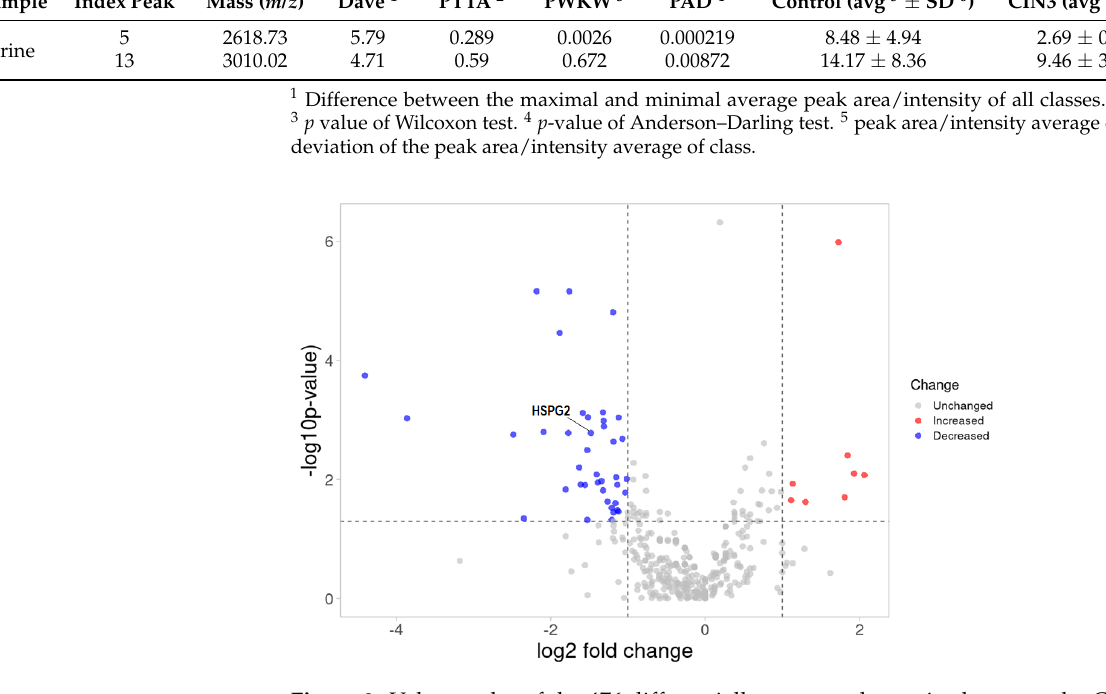
The biological function and key pathway enrichment of the gene set between control and CIN3 in the urine samples were analyzed using GSEA in the KEGG database. As a result, the enriched pathway was obtained, namely the ECM-receptor interaction (normalized enrichment score; NES = − 1.64, p = 0.026) shown on Figure 4A. The 16 core enrichment genes of the ECM-receptor interaction are shown in Figure 4B. In this pathway, a remarkably high number of genes were altered, e.g., of the all 88 proteins in the ECM - receptor interaction pathway, 15 showed a regulatory change using the Pathview Web Server (Figure 5). Among them were seven core enrichment proteins, i.e., a subset of genes that contributed most to the enrichment result (HSPG2, COL6A1, COL6A3, SPP1, THBS1, TNC, and DAG1). We found that the ECM-receptor interaction pathway was downregulated by 13 proteins (HSPG2, COL6A1, COL6A3, SPP1, THBS1, TNC, DAG1, FN1, COMP, GP6, VTN, SDC1, and CD44; log 2 FC range from − 0.03 to − 1.48) and up regulated by 2 proteins (TNXB and COL4A2; log 2 FC = 0.09 ─ 0.14) for the CIN3 group in the KEGG database. Among them, only HSPG2 was significantly changed (log 2 FC = − 1.48, p -value = 0.002) (Table S1, Figure 4B).